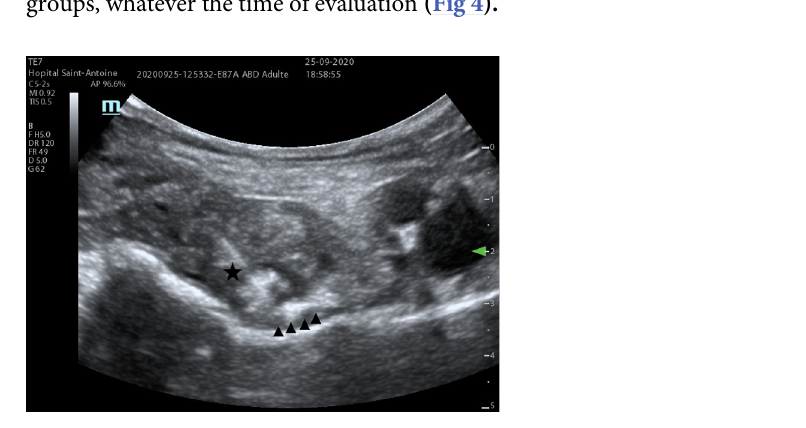
Fig 2. PENG block realization. Needle ( $ ) approaching the psoas tendon. ▲ represents injection zone under the psoas tendon. AIIS: Anterior inferior iliac spine, PT: Psoas tendon, IPE: Iliopublic eminence, FA: Femoral Artery, FV: Femoral